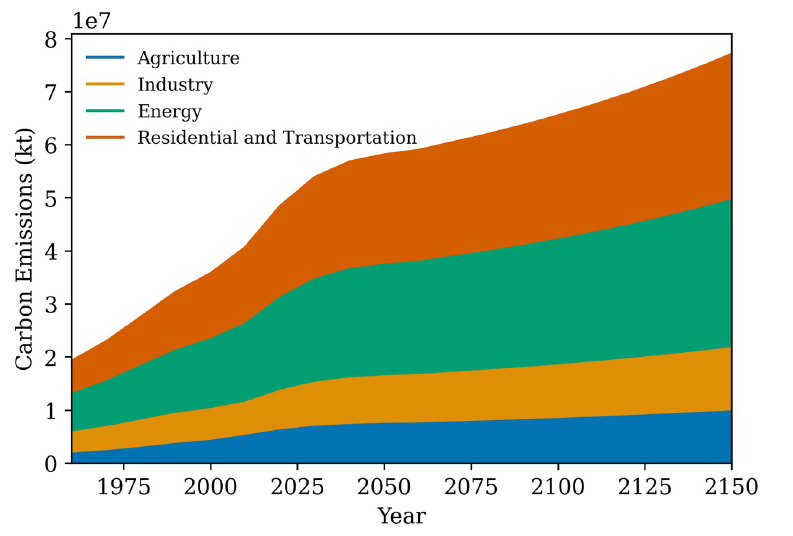
Fig 8. Sector wise carbon emissions (2010-2150) for base case